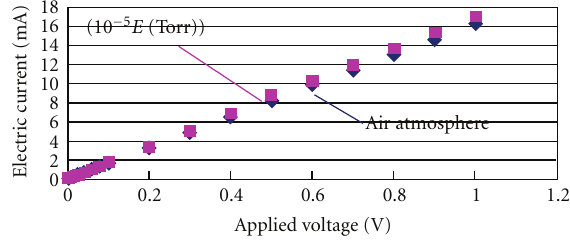
Figure 4: The I-V curves of a sample measured at room tempera- ture in an atmosphere and in a vacuum chamber of 10 − 5 Torr.